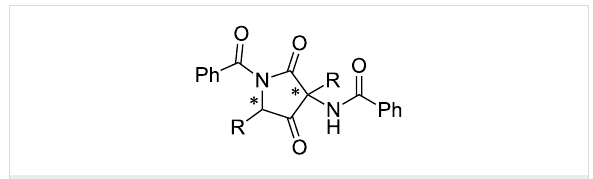
Figure 1: Structure of an azlactone